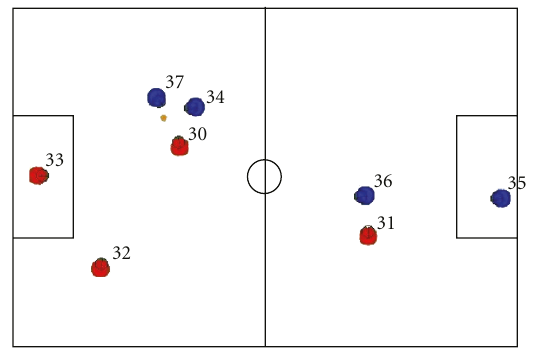
Figure 5: Simulation package used for evaluation of robot soccer algorithms. The robots are represented as red and blue